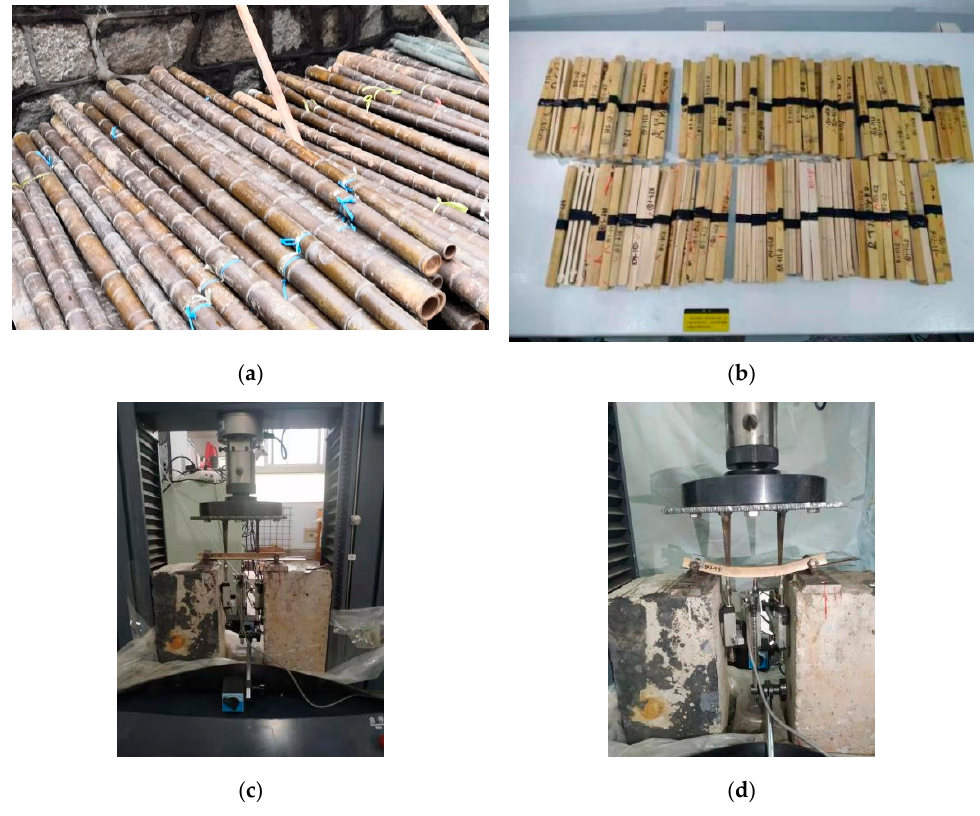
Figure 1. Test and destruction of P. edulis bamboo: ( a ) bamboo stalks; ( b ) specimens; ( c ) loaing; ( d ) specimen damage.